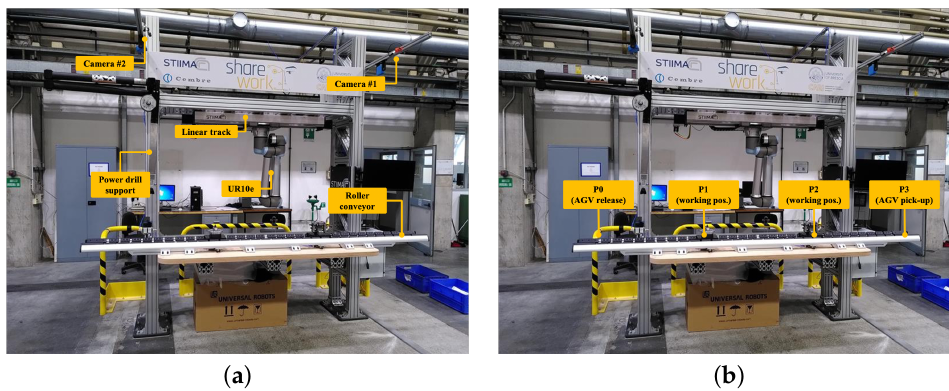
Figure 7. Demonstrator setup and description of the work positions: ( a ) Setup components; ( b ) Setup working